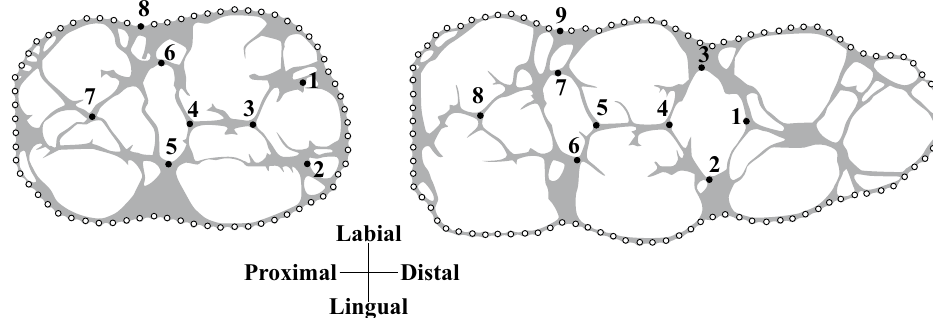
Figure 2. GM protocol for lower M/2 and M/3.